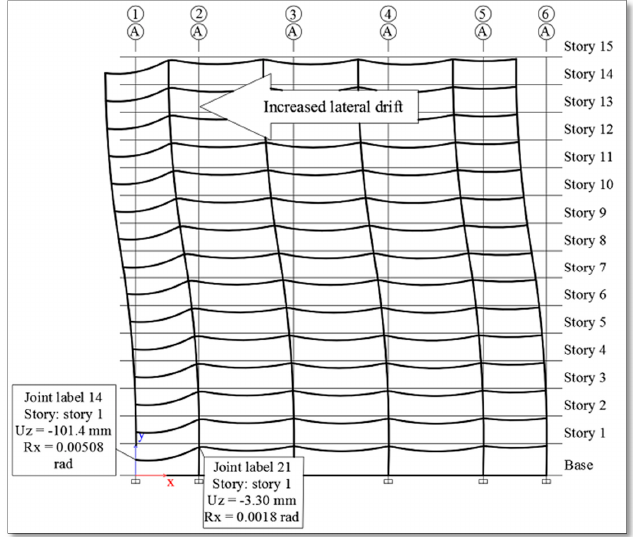
Figure 9. Deformation response of the structure at grid line A due to the notional removal of column A1 when moment frames are located at perimeters and along grid lines B, C, D, E, F and G (load case 16, non-linear dynamic analysis).